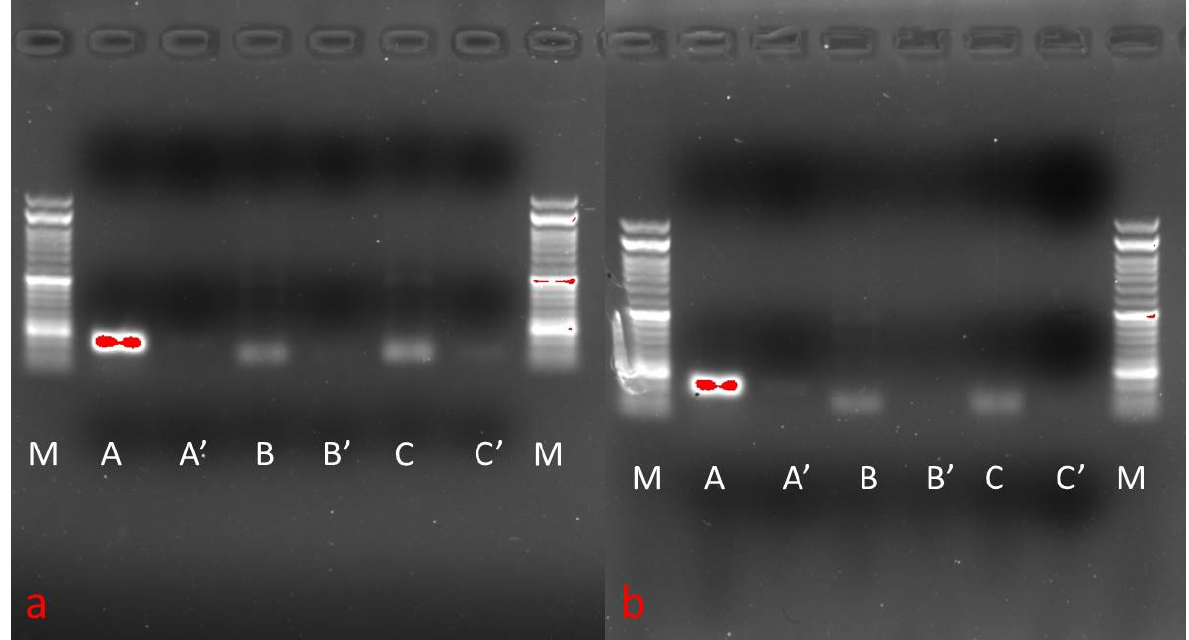
Figure 6. The expression analysis of genes of adipose tissue MSCs ( a ) and bone marrow MSCs ( b ) for different differ- entiation markers. M: 50 bp Ladder. The differentiation markers expressed are PPARG (Adipogenic: A differentiated; A (cid:48) undifferentiated), BGN (Chondrogenic: B differentiated; B (cid:48) undifferentiated) and BGLAP (Osteogenic: C differentiated; C (cid:48)